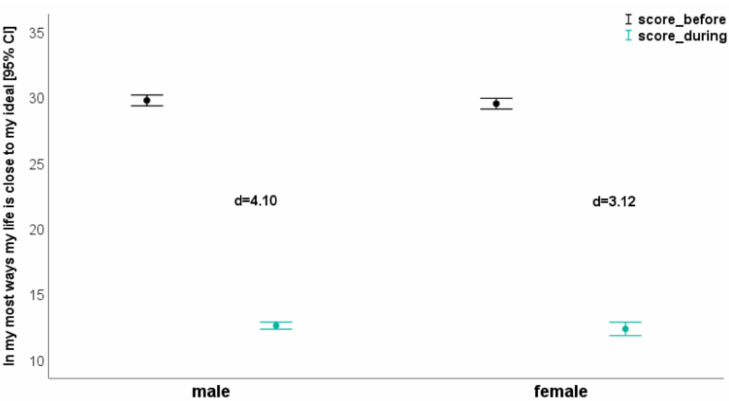
Figure 3. In my most ways, my life is close to my ideal—depending on gender before and dur- ing